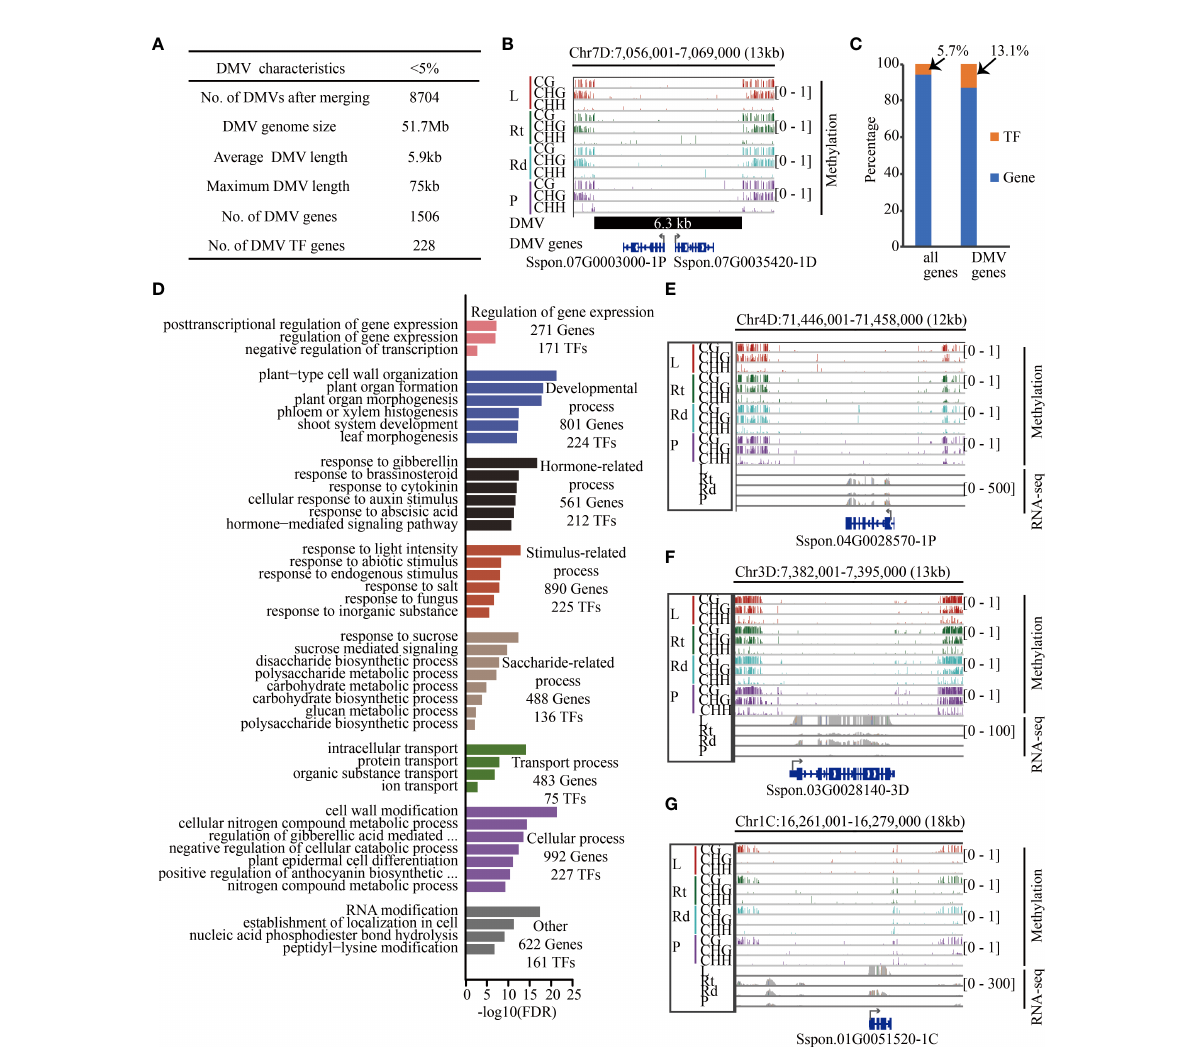
FIGURE 6 Transcription factors are enriched in sugarcane DMVs. (A) Summary of sugarcane DMV characteristics. (B) IGV of an 18-kb DMV located on chromosome 7D. Genes in blue color (Sspon.07G0003000-1P and Sspon.07G0035420-1D encoding the pectin lyase-like superfamily are involved in carbohydrate metabolic process) are located within this DMV, including 1 kb of 5 ′ and 3 ′ fl anking regions. (C) Proportion of TF in genome and DMV regions. (D) Enriched GO terms with an FDR < 0.05. (E – G) Methylome and RNA-Seq genome browser views of three genes between at least two tissues. Red, green, cyan, and purple bars indicate leaf, root, rind, and pith, respectively. Gray collapsed bars indicate expression level. L, leaf; Rt, root; Rd, rind; P, pith; DMV, DNA methylation valley; TF, transcription factor; IGV, integrative genomics